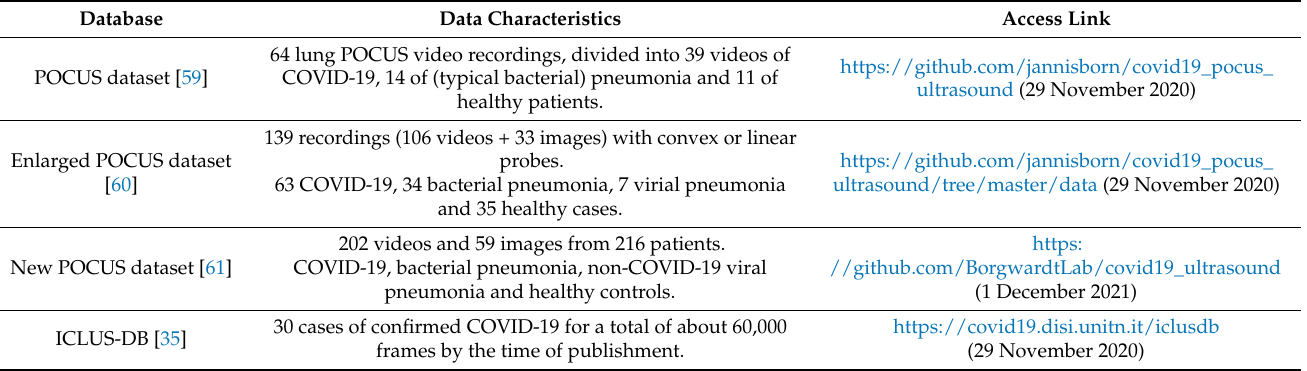
Table 1. Large online open databases of COVID-19 ultrasound